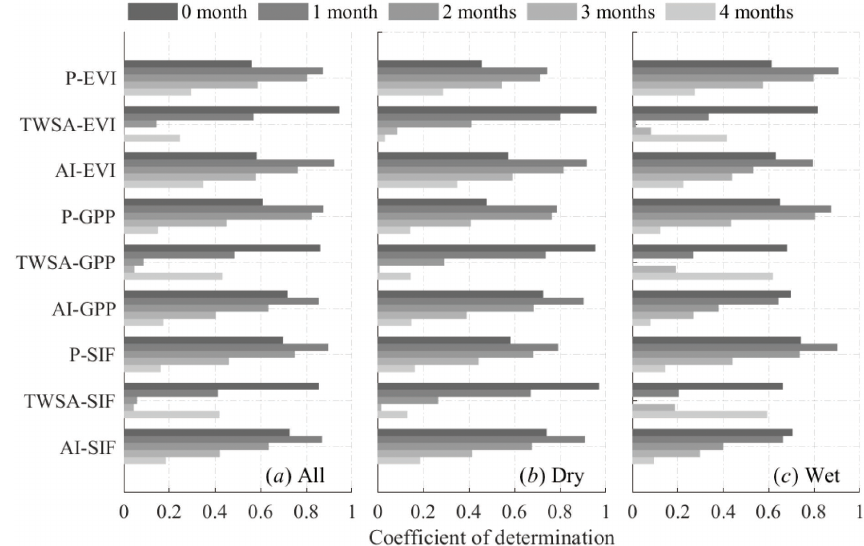
Figure 9. Coefficient of determination between monthly climatological means of the anomalies of precipitation ( P ), total water stor- age (TWS), aridity index (AI), enhanced vegetation index (EVI), solar-induced chlorophyll fluorescence (SIF), and gross primary pro- duction (GPP) in (a) all years, (b) the dry years, and (c) the wet years after shifting a different number of months, as indicated in the